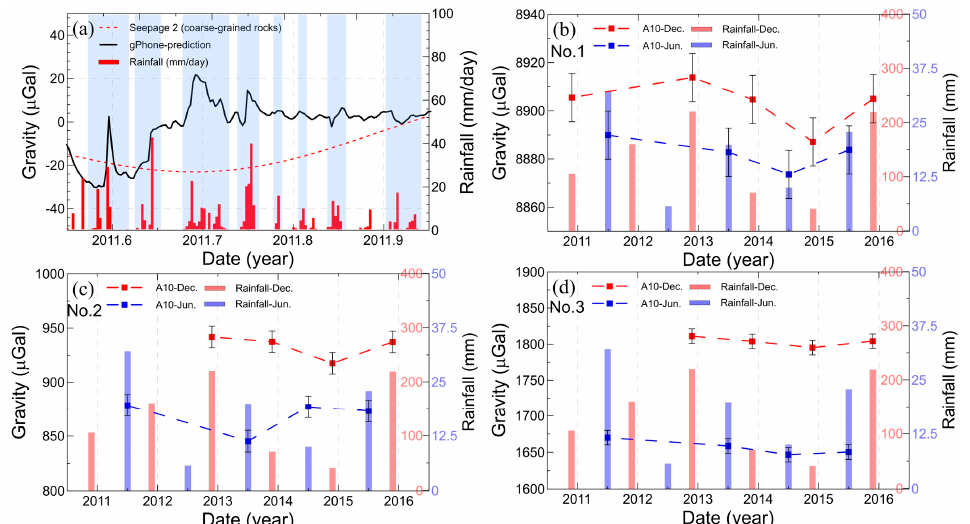
Figure 10. ( a ) Gravity residuals from gPhone observations, corrected for predicted leakage effects due to TGR filling. ( b – d ) A10 absolute gravity measurements at two levels (145 m and 175 m) for 3 stations in the network (Figure 2); the error bars of A10 represent total measurement uncertainty at ~10 micro-gals ( μ Gal) levels. Lower plots in ( a – d ) show daily and monthly rainfall changes at the Zigui weather station.